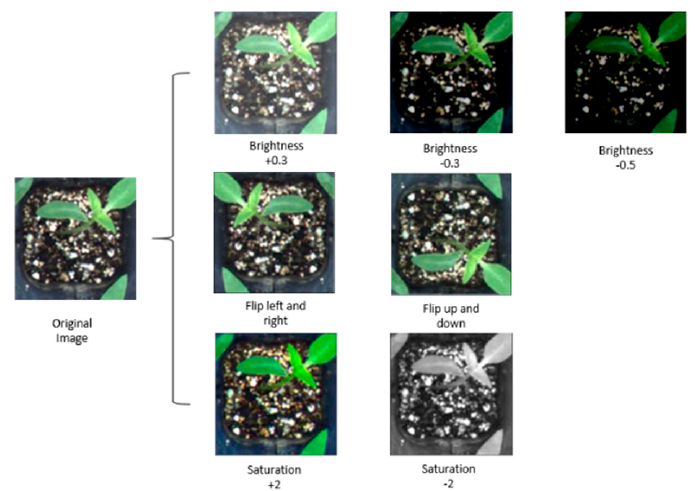
Figure 7. Data augmentation examples.